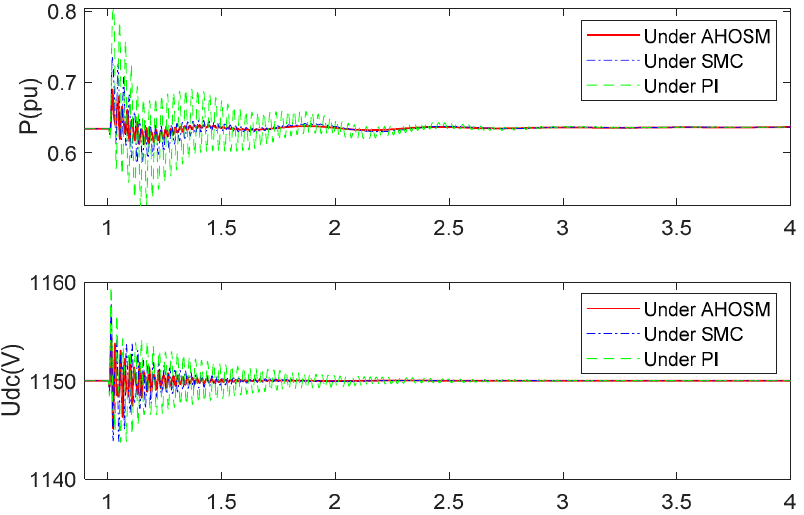
Figure 14. Responses of active power and DC link voltage under three control methods with series ‐ compensated level 30% and wind speed 11 m/s.